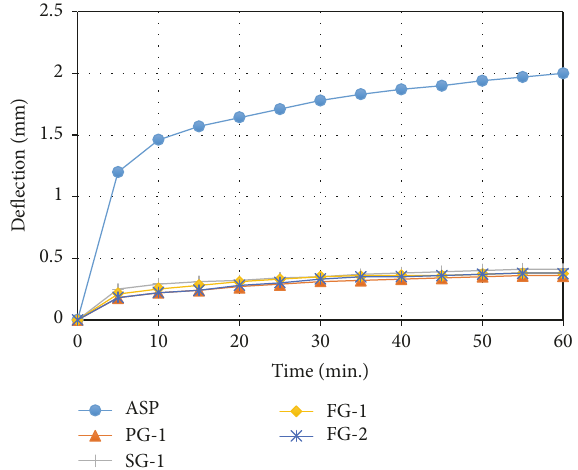
Figure 9: Results of wheel tracking test of asphalt skeleton and semirigid asphalt